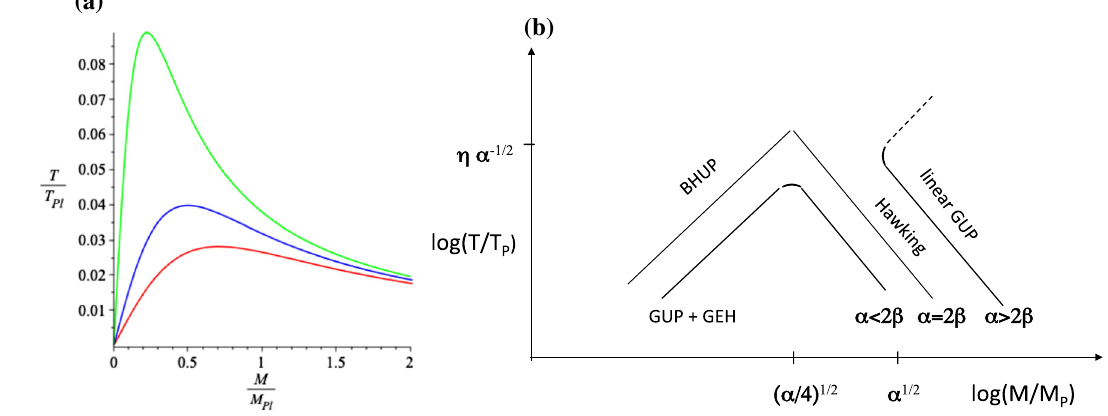
uration with M = T = 0. b This gives the temperature in the more general case with both α and β for α < 2 β (cf. ‘ M + 1 / M ’ model), α = 2 β (cf. Hawking solution) and α > 2 β (cf. Adler’s solution)